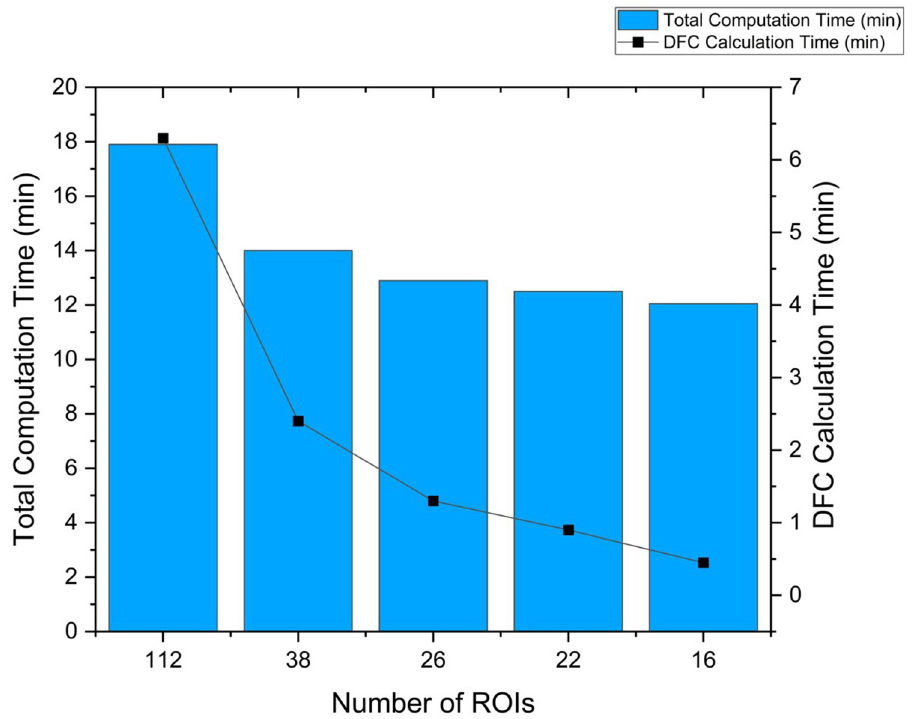
Fig 7. Time taken for data processing up to prediction, varying the number of ROIs